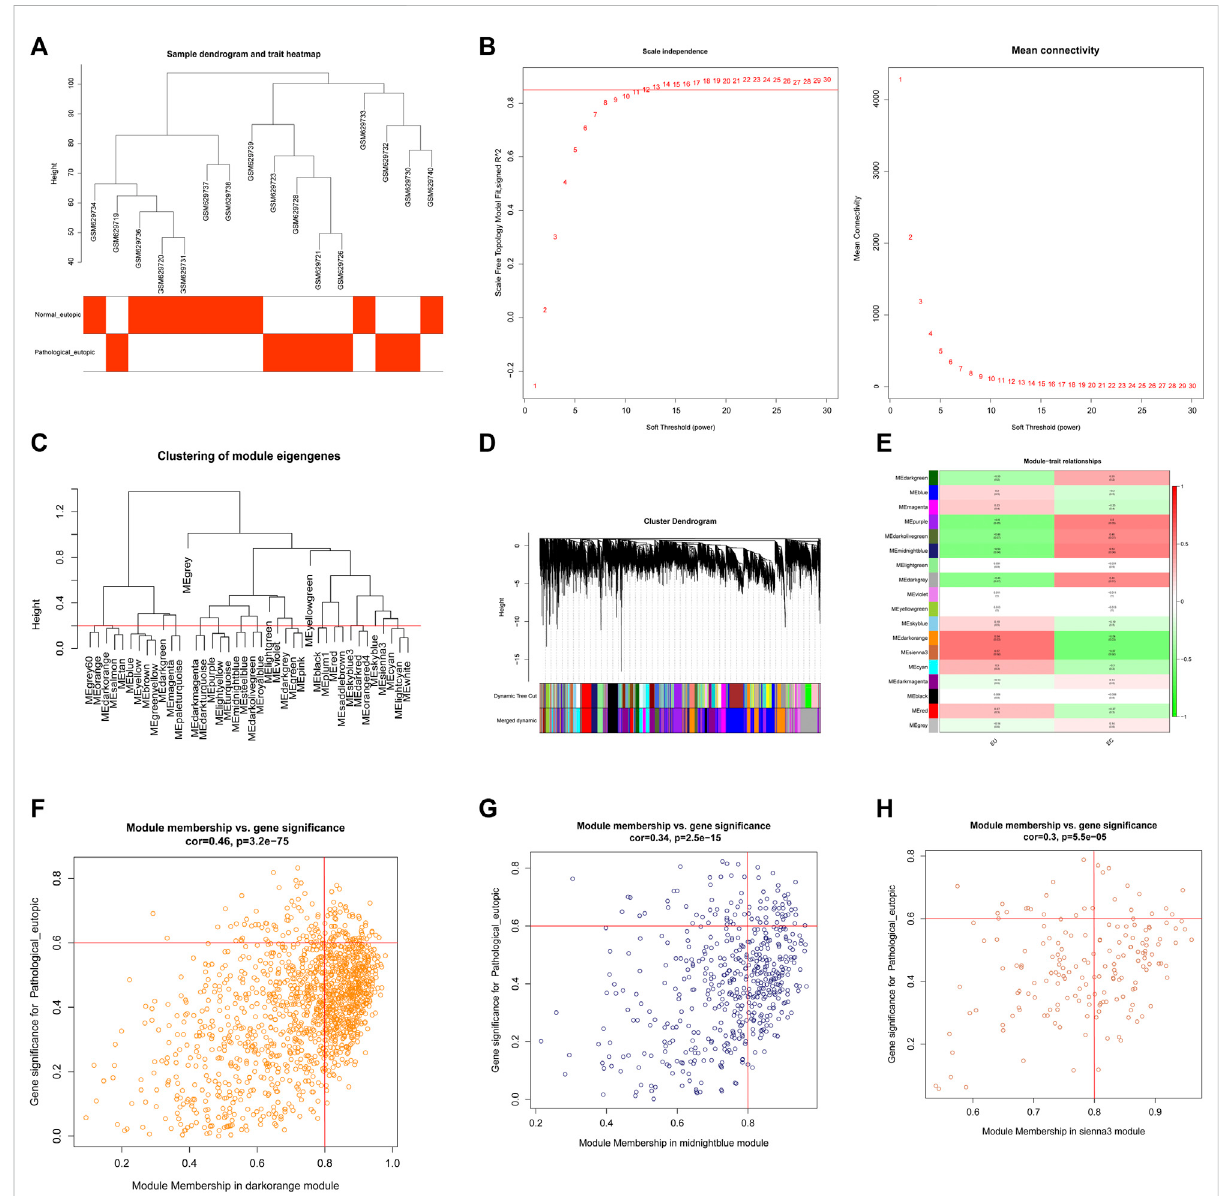
FIGURE 2 Construction and module analysis of weighted gene co-expression network analysis (WGCNA). (A) Clustering and phenotypic information of combineddatasamples,theupperpartofthe fi gureisclustering,andthelowerpartisphenotype.Thecolorrepresentsdisease. (B) Determinationof the soft threshold. (C) Merging of the similar modules analyzed by the dynamic cutting tree algorithm. (D) Clustering dendrogram of genes with different similarities based on topological overlap and the assigned module color. (E) The heat map of correlation between different modules and clinical characters. The ordinate represents different modules and the abscissa represents different traits. Each block represents the correlation coef fi cient and signi fi cance p value of a module and a trait. (F) Module membership in sienna3 module, the vertical line is |MM| = 0.6 and the horizontal line is |GS| = 0.8. The key gene of the module we selected is in the box of the upper right corner of the fi gure. (G) Module membership in darkorange module, the vertical line is |MM| = 0.6 and the horizontal line is |GS| = 0.8. The key gene of the module we selected is in the box of the upper right corner of the fi gure. (H) Module membership in midnightblue module, the vertical line is |MM| = 0.6 and the horizontal line is |GS| = 0.8. The key gene of the module we selected is in the box of the upper right corner of the fi